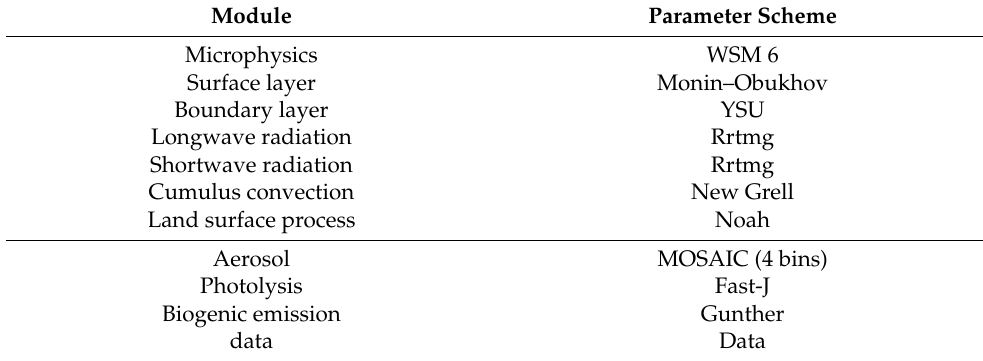
Table 1. WRF-Chem Configuration. Module Parameter Scheme Microphysics WSM 6 Surface